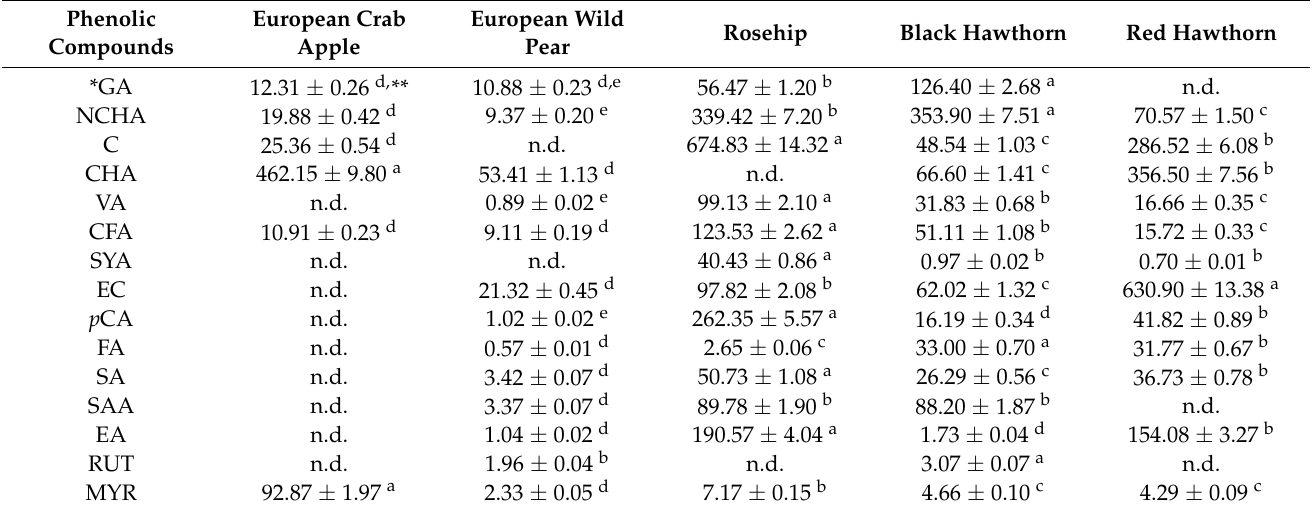
Table 2. Phenolic compounds’ content (mg L − 1 ) of the homemade